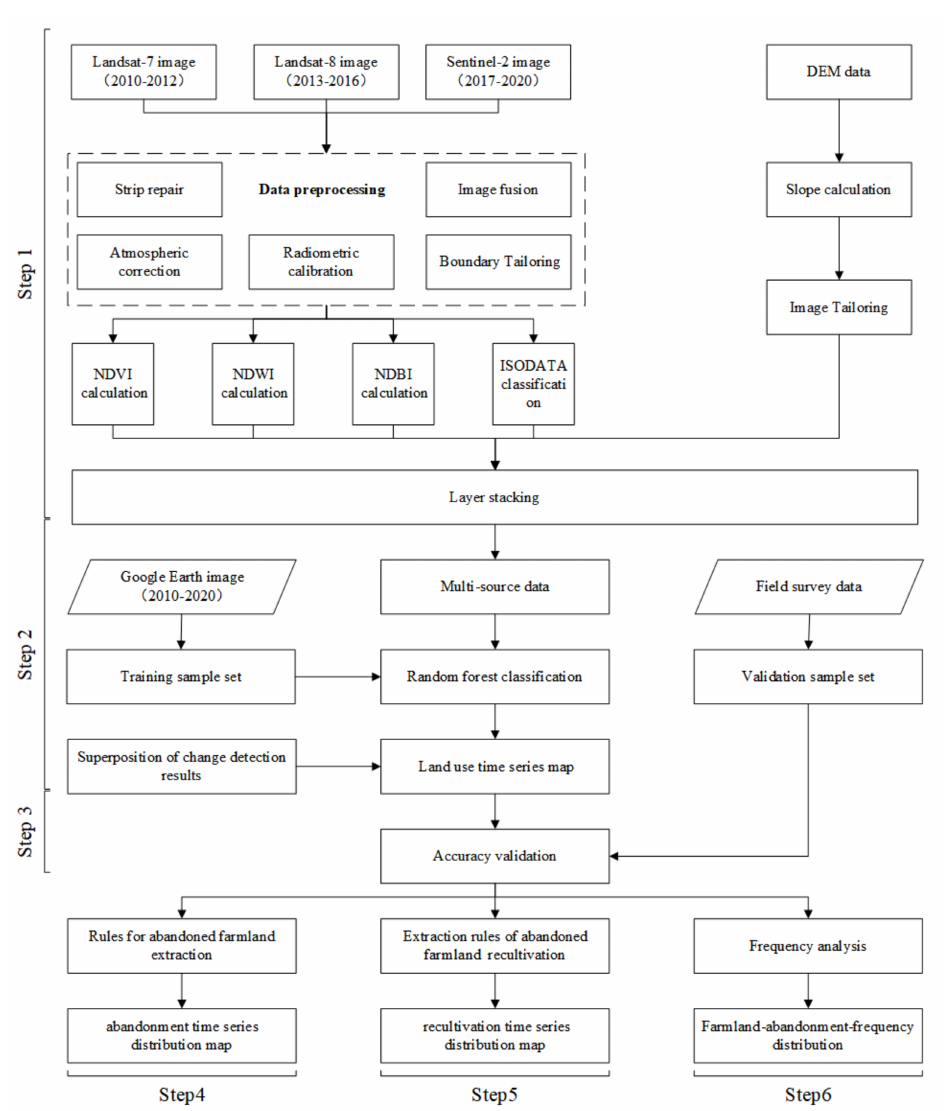
Figure 4. Flowchart of the methods for this